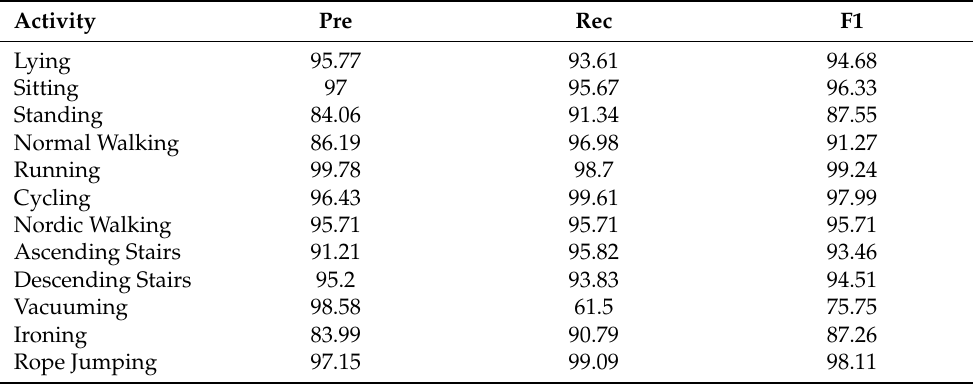
Table 7. Classification rates (%) of the best model of the PAMAP2 dataset using